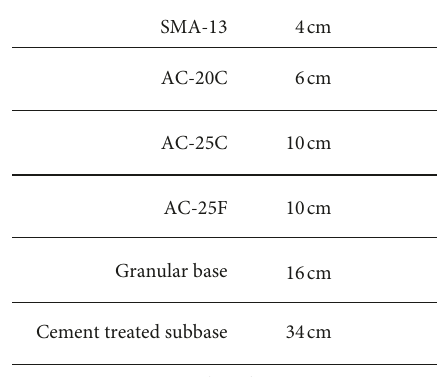
Figure 2: Test road pavement structure II.